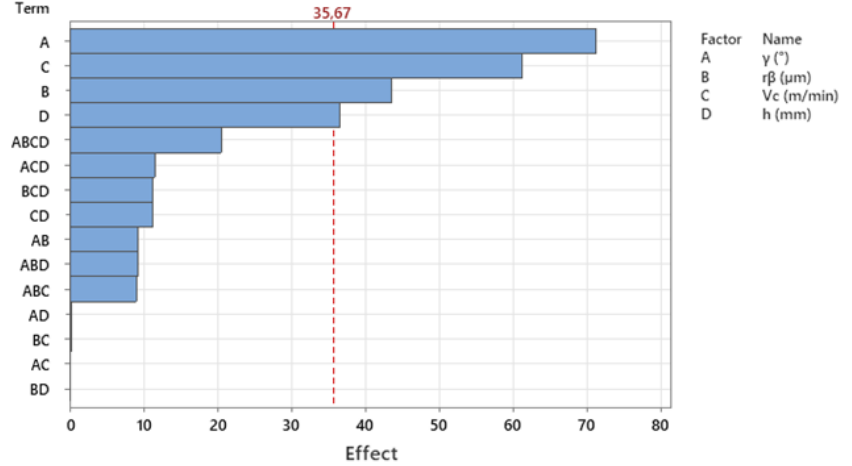
Figure 13. Pareto analysis of the factors affecting the residual stresses in the transversal direction ( SRST ) based on all cutting conditions.